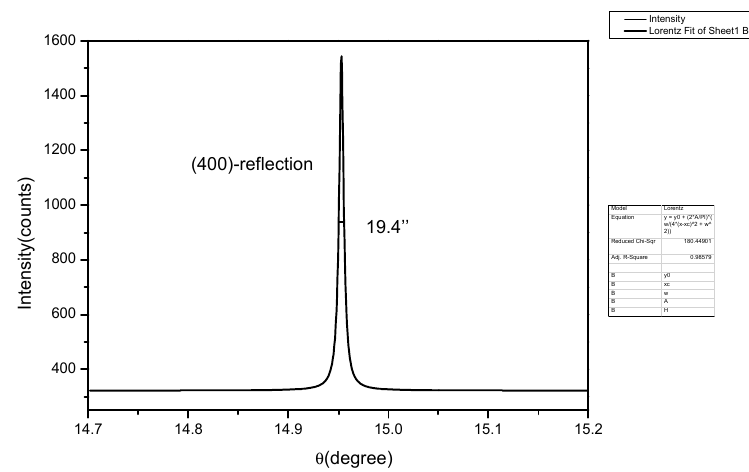
Figure 2. X-ray rocking curve of LTO single crystal.